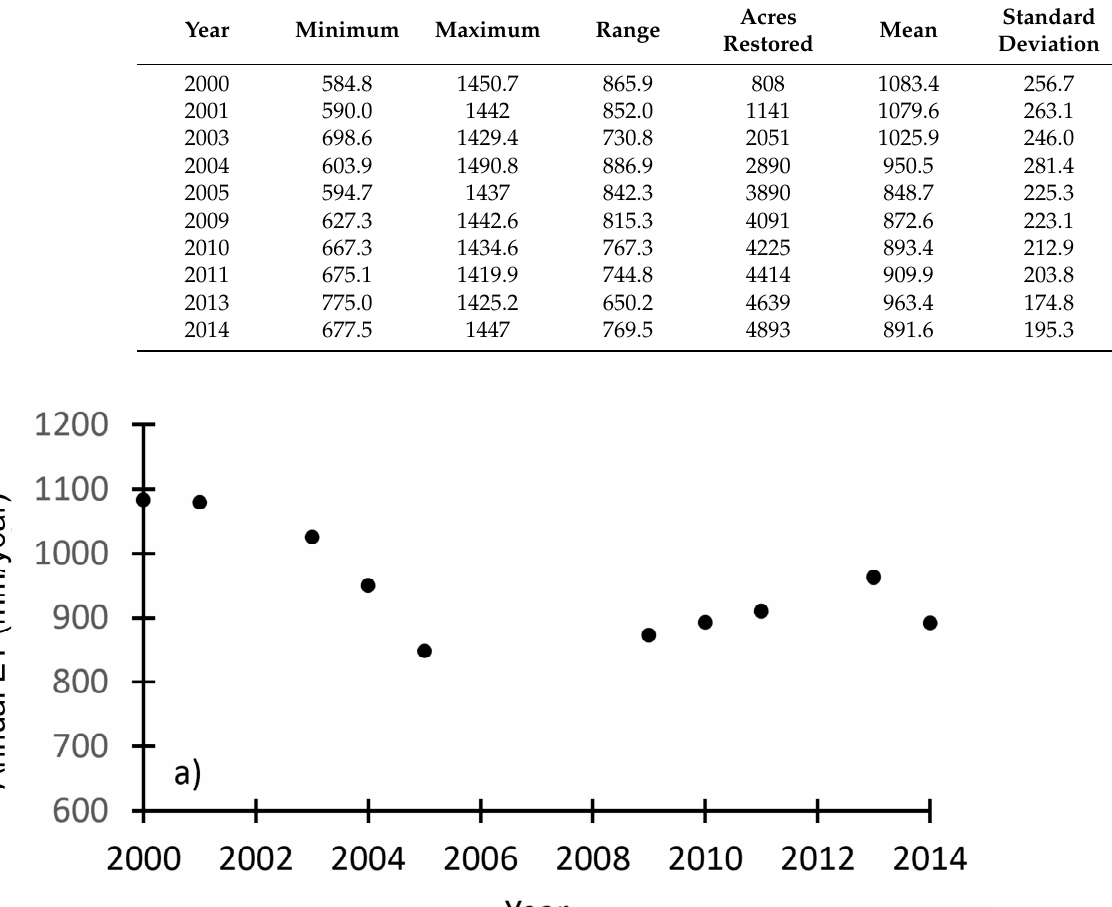
Table 1. Summary statistics of ET for each year of restoration [42]. Values reported in mm year − 1 .